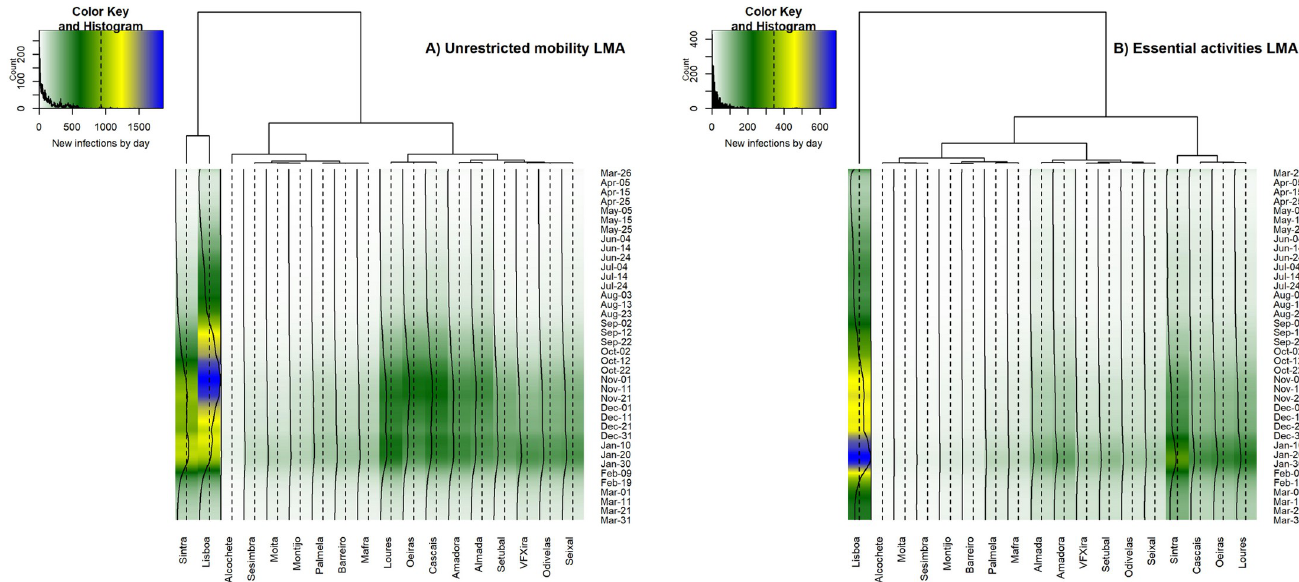
Fig 7. Time-series clustering of the daily new infected in the municipalities of LMA, for the simulation regarding the unrestricted mobility of 2011 (A, left) and restricted to essential activities (B, right). The color key is the same for both metropolitan areas and mobility scenarios, to facilitate visual comparisons, but the range of values (new infections by day) differs. Obtained with dtwclust package in R software [37].